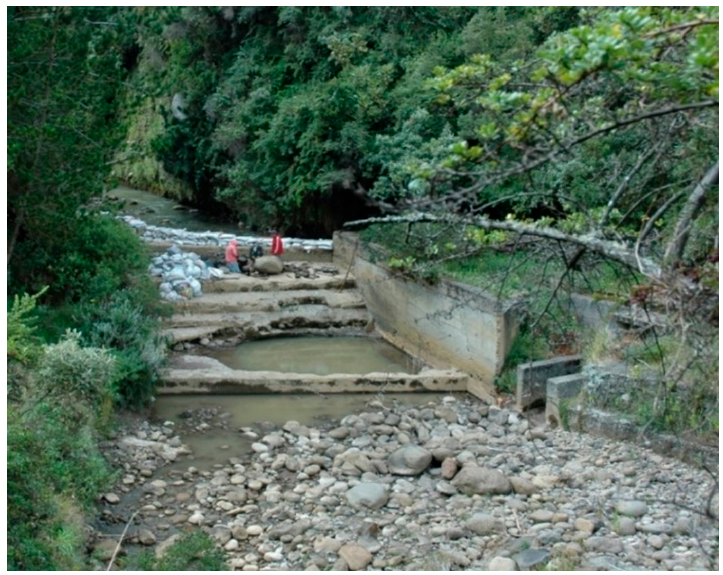
Figure 7. The water intake for the El Calvario canal in the community of La Chimba in the dry season and the riverbed that runs out of water for the other community concessions.